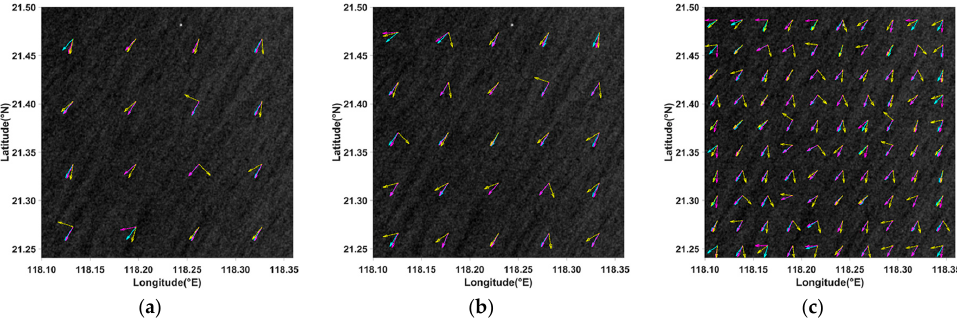
Figure 8. Wind directions retrieved by the three methods from 75 m pixels on different grids of the ASAR image in Figure 2b: ( a ) 7.5 km grid, ( b ) 6 km grid, ( c ) 3 km grid. Yellow, magenta and cyan arrows indicate wind directions retrieved by the FFT-like, LG-like and ILG methods, respectively.